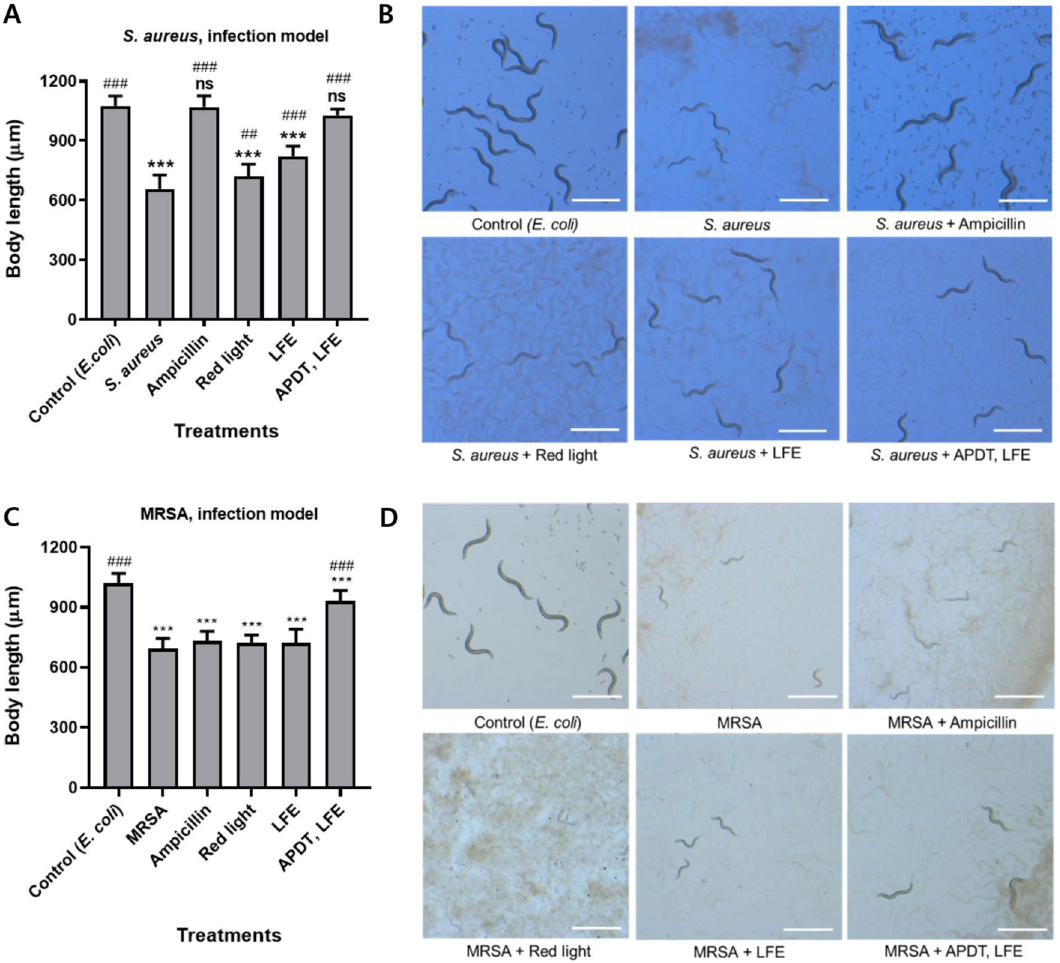
Fig. 6 Effect of APDT‑LFE on the growth rate of C. elegans in MRSA and S. aureus infection model. Eggs were fed with LFE‑incubated MRSA or S. aureus (LFE concentration:20 µg/mL; incubation time: 30 min) or ampicillin as the positive control. NGM plate coated with E. coli was used as vehicle control. After reaching the L1 stage, the plates were irradiated with a red light at 600 W/m 2 for 10 min. The body length A , C and the microscopic images of the worms B , D were evaluated on the fourth day after the egg state. The results are representative of three independent experiments. White scale bar 1 mm. Analysis of variance test (n 10). ns indicates no statistical significance relative to the control group; significant differences = = are expressed with *** for p < 0.001 relative to the vehicle control group; ## for p < 0.01, ### for p < 0.001 relative to the pathogen single